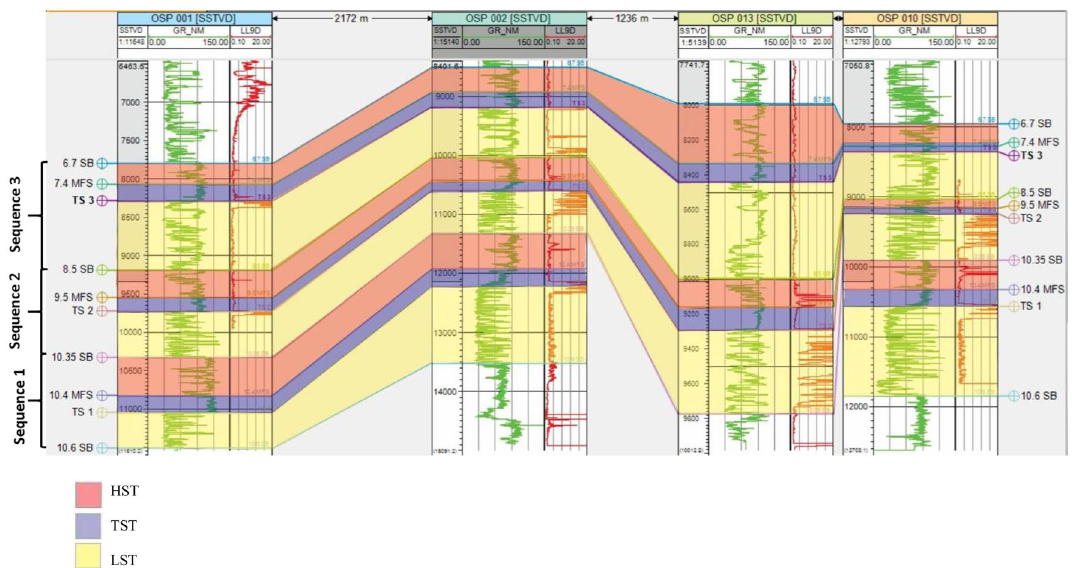
Fig. 10 Stratigraphic surfaces and systems tracts across OSP field